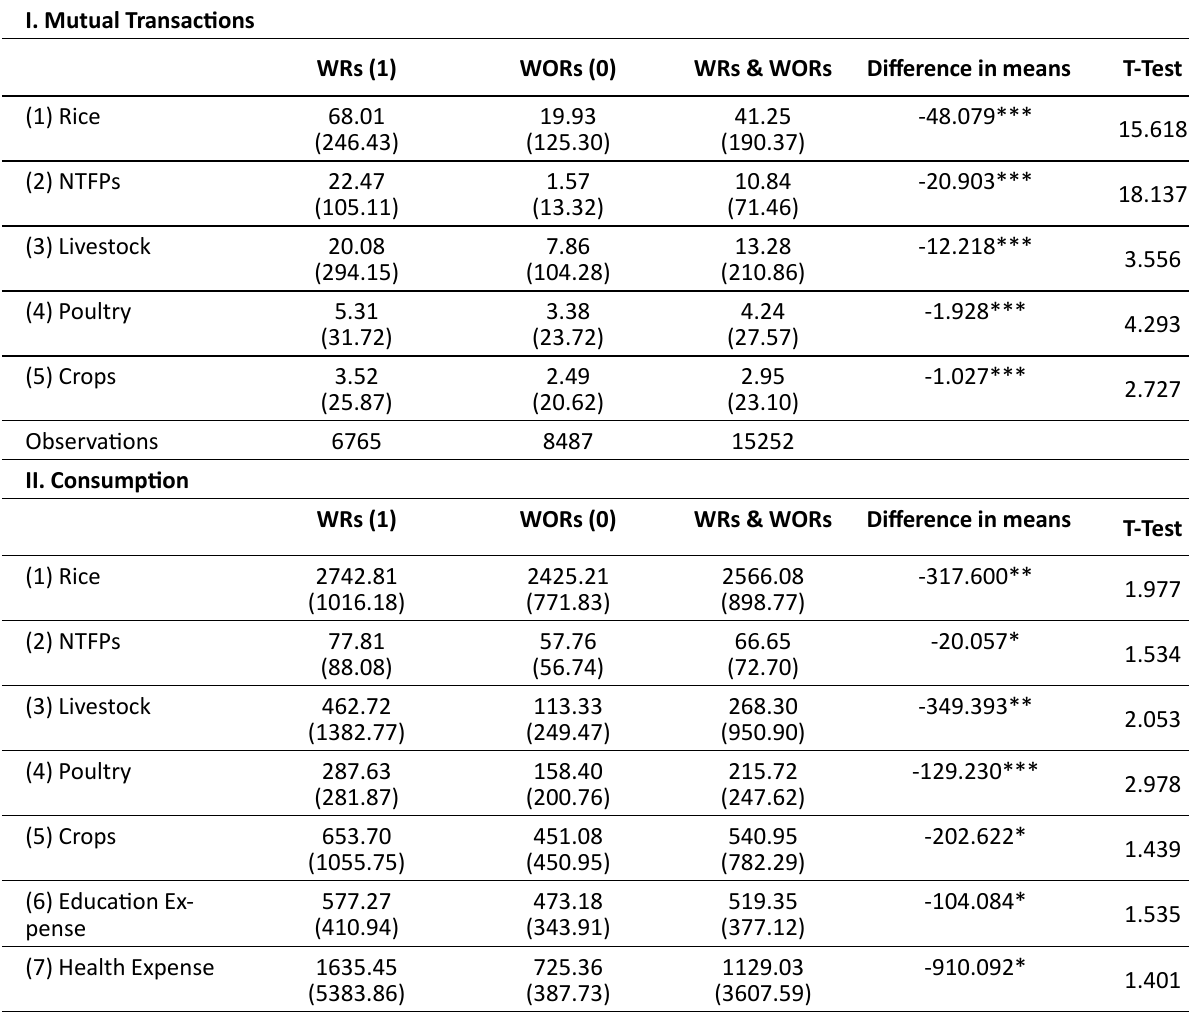
Table 3: Summary Statistics by Remittance Status- Mutual Transactions, Consumption, And Investment,